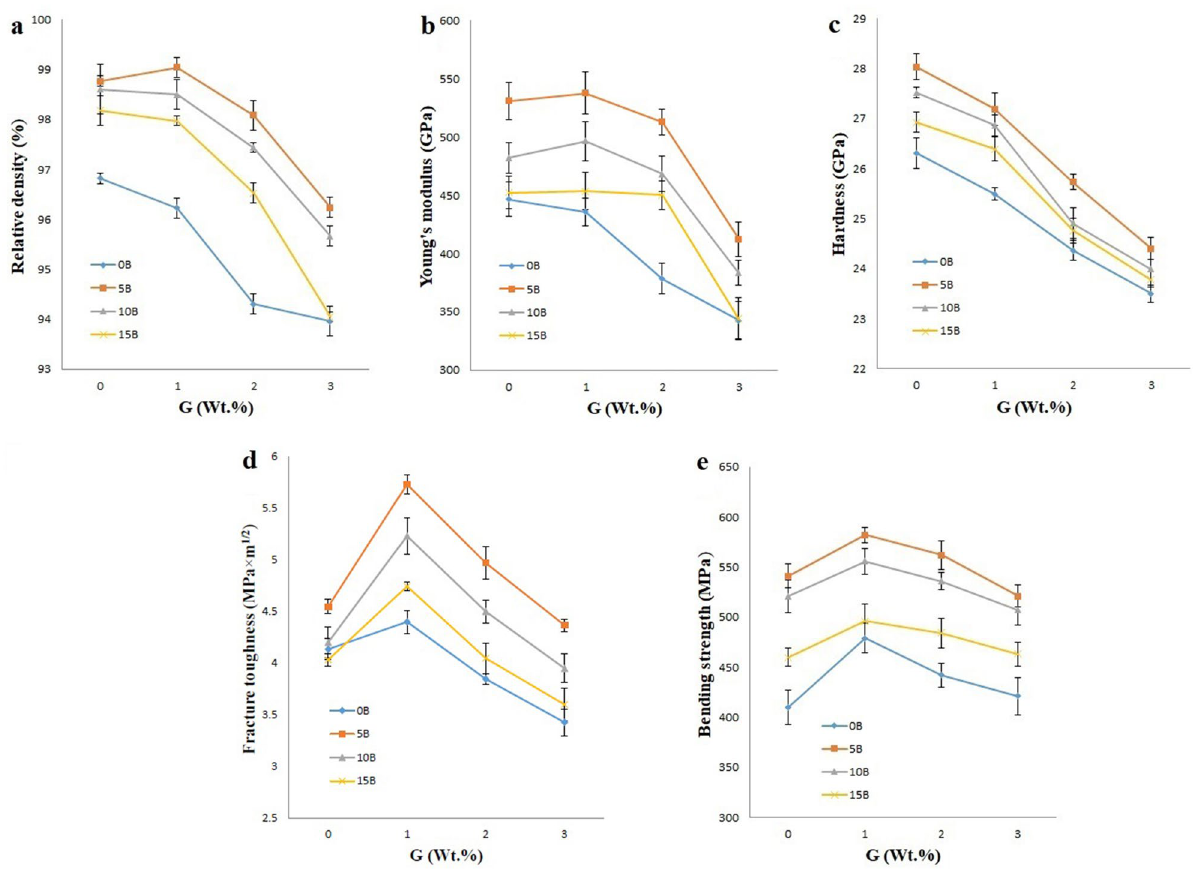
Figure 3. Changes in ( a ) Relative density, ( b ) Young’s modulus, ( c ) Hardness, ( d ) Fracture toughness and ( e ) Three-point Bending strength with different percentages of graphene and nano